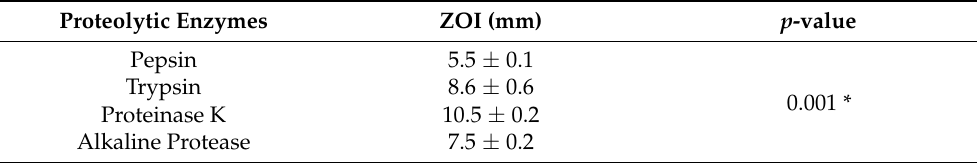
Table 4. Inhibitory effects of enterocin in presence of proteolytic enzymes against